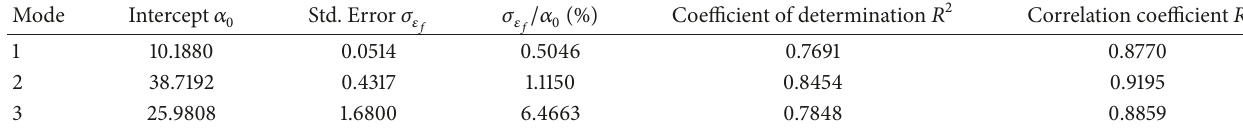
Table 9: Coefficients of linear regression model (frequency ∼ temperature + humidity) of girder No. 2.